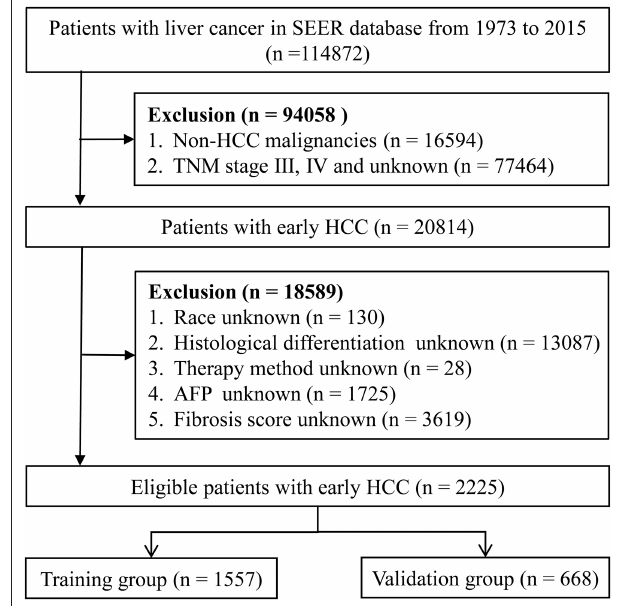
FIGURE 1 | Flow diagram for selecting early HCC patients. SEER, the Surveillance; Epidemiology, and End Results database; HCC, hepatocellular carcinoma; AFP, alpha